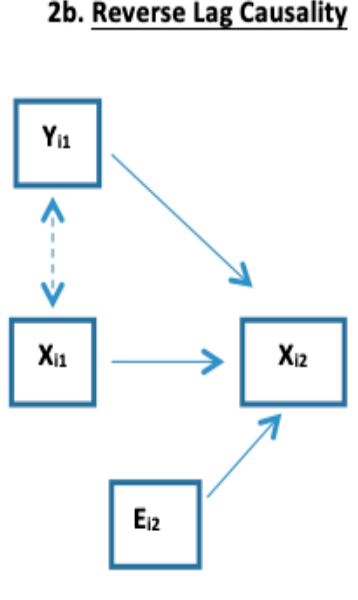
Figure 2. Illustration of lag causality and reverse-lag causality for K = 1.